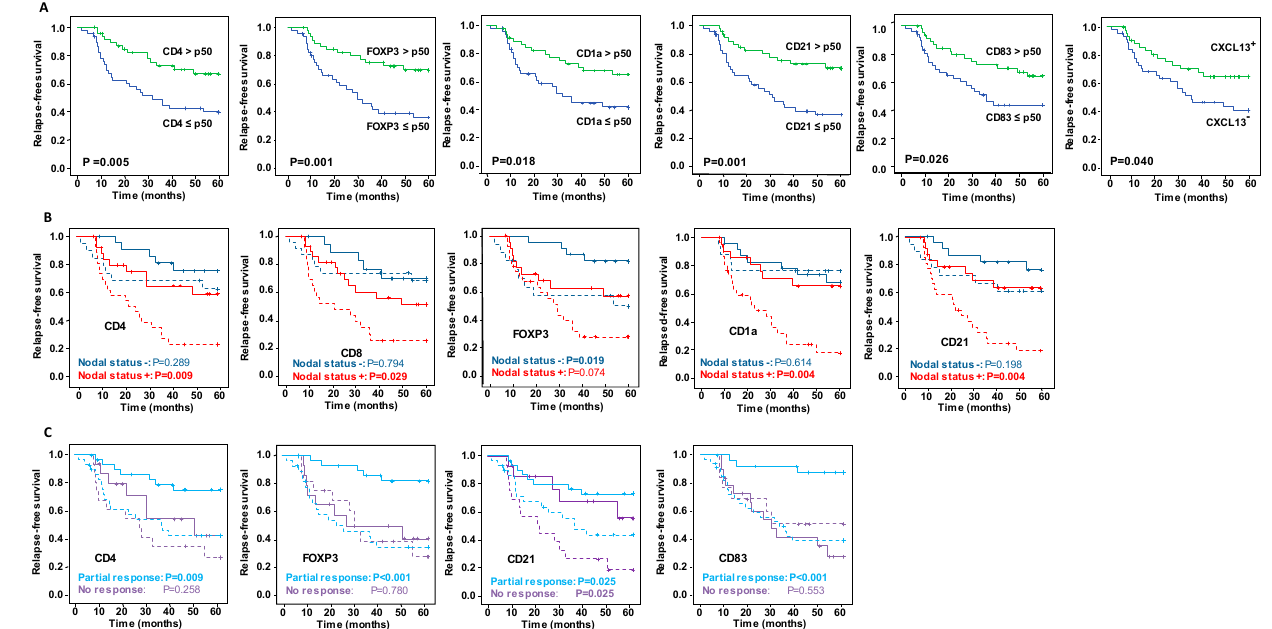
Figure 2. Kaplan–Meier analysis of five-year relapse-free survival (FRS) with respect to significant immunohistochemistry (IHC) and mRNA markers expression. ( A ) Kaplan–Meier analysis of RFS among all patients. ( B ) Superimposed Kaplan–Meier curves of RFS stratified by nodal status at di ‐ agnosis, and ( C ) depending on the type of response after NAC. In the plots in B and C, the continu ‐ ous lines show the RFS of patients with IHC immune marker concentrations greater than the median of all patients or when mRNA markers were expressed, and the dashed lines show the RFS when IHC immune markers concentrations were less than the median of all patients or when mRNA markers were not expressed. Significance of the log ‐ rank test is indicated in the figures, with signif ‐ icant differences between variables indicated by probabilities highlighted in bold.